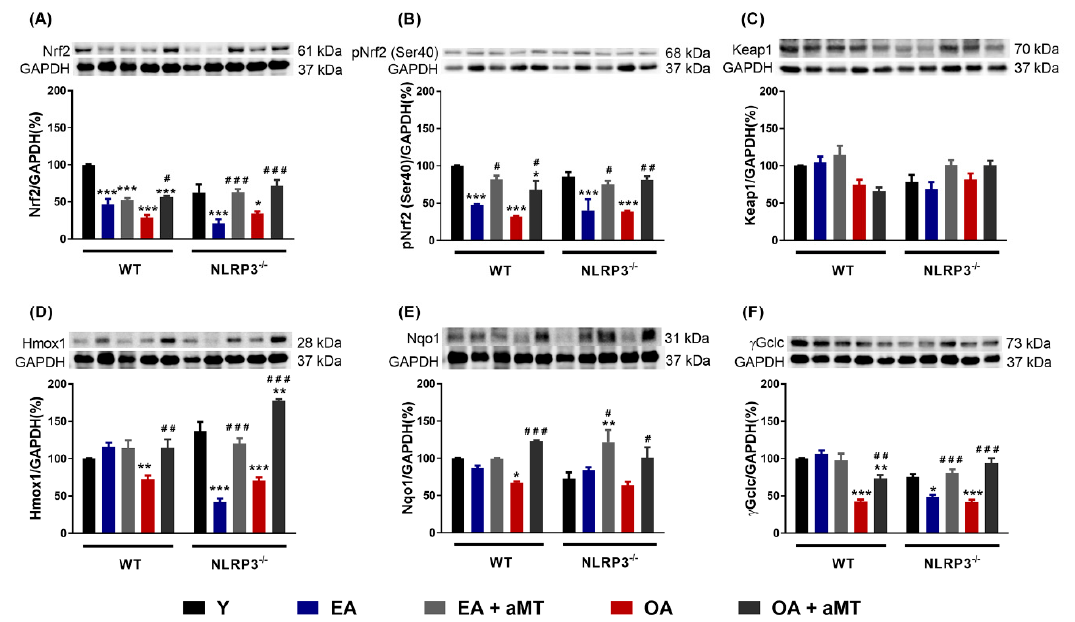
Figure 5. Changes in the Nrf2-dependent antioxidant pathway in WT and NLRP3 − / − mice during aging and melatonin treatment. ( A ) Protein levels of Nrf2. ( B ) Protein levels of pNrf2 (Ser40). ( C ) Protein levels of Keap1. ( D ) Protein levels of Hmox1. ( E ) Protein levels of Nqo1. ( F ) Protein levels of γ Gclc. Experiments were performed in hearts of young (Y), early-aged (EA), early-aged with melatonin (EA + aMT), old-aged (OA), and old-aged with melatonin (OA + aMT) wild type and NLRP3 − / − mice. Data are expressed as means ± SEM ( n = 7 animals / group). * p < 0.05, ** p < 0.01, *** p < 0.001 vs. Y; # p < 0.05, ## p < 0.01, ### p < 0.001 vs. group without melatonin treatment.